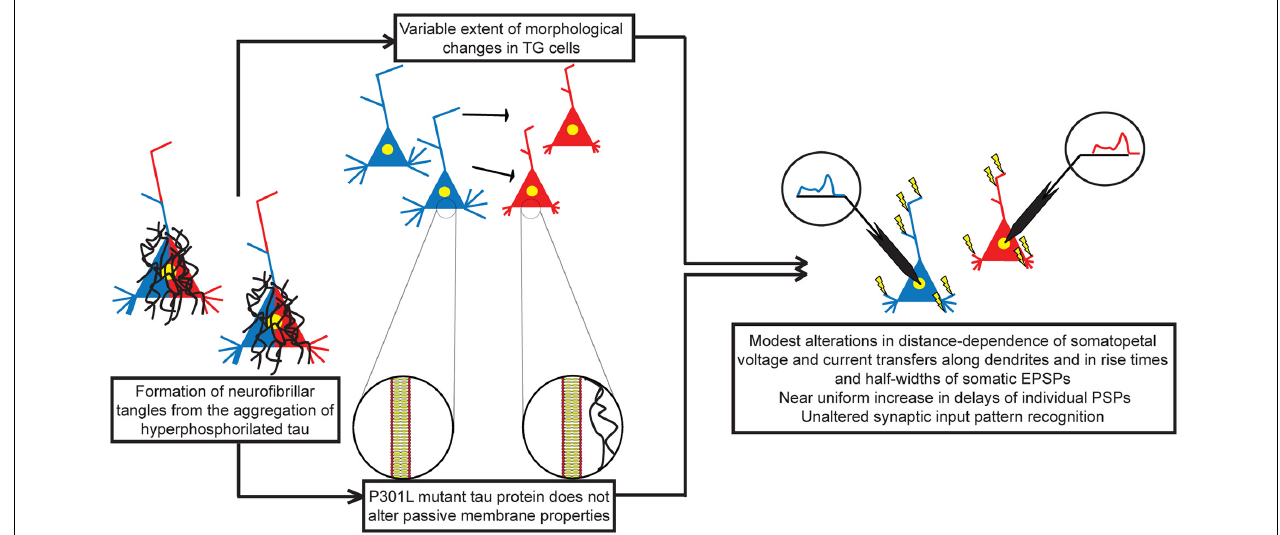
FIGURE 13 | Morphofunctional effects of human P301L mutant tau protein on layer III pyramidal neurons in the rTg4510 mouse model of advanced tauopathy. Mutation in tau protein leads to aggregation and formation of NFTs. Mutant tau protein detaches from microtubules leading to destabilization of the cytoskeleton and atrophy of dendrites. On the other hand, mutant tau protein does not alter passive membrane properties, such as specific membrane resistance and capacitance of neurons. Therefore, detected alterations in subthreshold dendritic signaling of individual PSPs are entirely due to alterations in morphology of tau-mutant neurons. Alterations in voltage and current transfers as well as in rise times and half-widths of somatic EPSPs are limited spatially to PSPs produced by only a fraction of synapses, and these alterations are relatively small in size. Time delays between synaptic activity and somatic voltage response show general significant increase in TG neurons, and sizes of these increases are nearly independent of the dendritic location of synapses. Restricted alterations in transfers/rise times/half-widths and the uniform increase in delays of PSPs may leave synaptic integration unchanged, leading to unaltered input pattern recognition/discrimination in advanced tauopathy. WT neurons in blue, TG neurons in red colors, and neurons with both colors are in the process of getting altered.